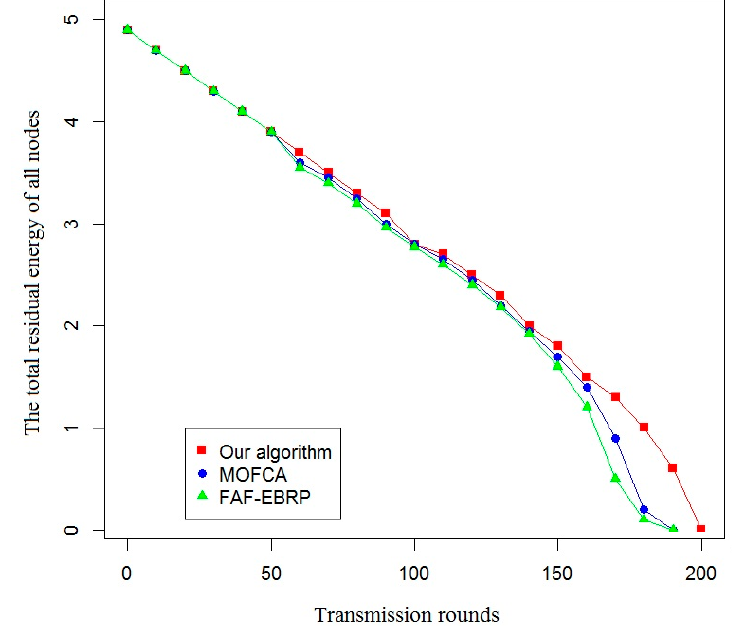
Figure 8. Comparison of the total residual energy of all nodes.